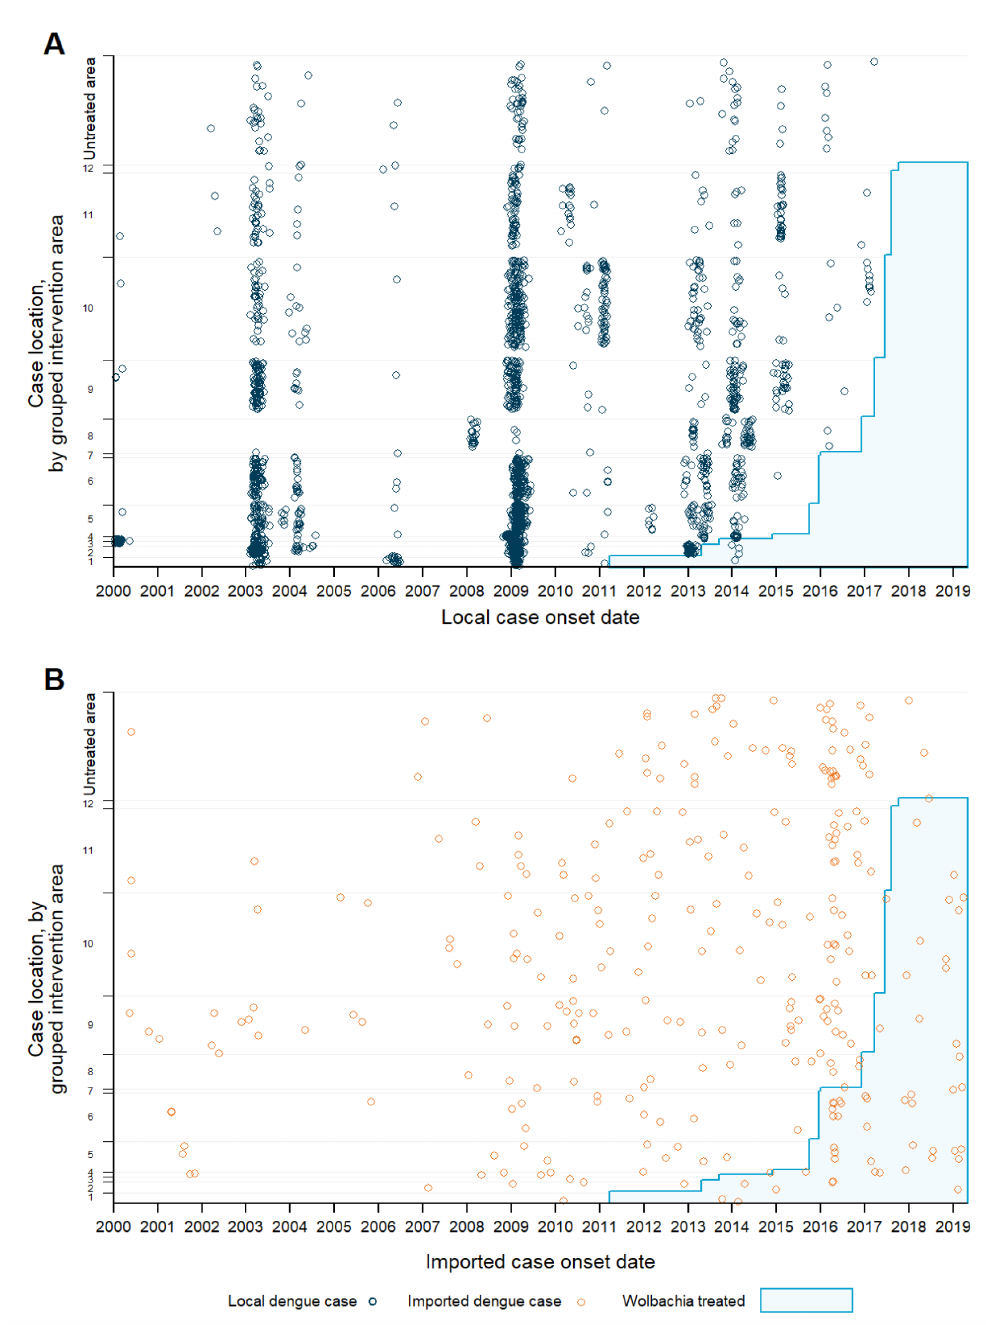
Figure 18. Notifications of locally-acquired ( A ) and imported ( B ) dengue cases relative to Wolbachia deployments, in Cairns, Cassowary Coast, Charters Towers and Douglas local government areas, January 2000 – March 2019. Cases are plotted by date of illness onset, and by grouped intervention area determined from geolocated address, or from suburb where address was unavailable. Intervention areas were grouped by the calendar quarter in which releases were completed or, for the five central Cairns non-release areas where Wolbachia established, the inferred date when local Wolbachia frequency reached 80%. Cases located in the four LGAs, but outside of any Wolbachia established area, are shown in ‘Untreated area’ at the top of each graph. The Y-axis scale is proportionate to the population size of each intervention area (or untreated area). The grouped intervention areas, and the quarter in which they were considered Wolbachia -treated for epidemiological purposes, were as follows: Group 1: Q1 2011 (GV, YK); Group 2: Q2 2013 (EHW, PP, WC); Group 3: Q3 2013 (BA, MB); Group 4: Q4 2014 (BU1, BU3, CN1, SF1-3); Group 5: Q3 2015 (MDA, MRA, BUN NR, EA); Group 6: Q4 2015 (M BU2, BUX1, BUX2, MDA NR1, MDA NR2, MS, OO, WCX1, WCX2, WO, WR); Group 7: Q1 2016 (WC NR); Group 8: Q4 2016 (CB, CT, MG, MN, MO, PD); Group 9: Q1 2017 (BP, CNX, EDM); Group 10: Q2 2017 (BEL, BH, BRN, BUX3, EHX, FFP, IAE, IES, INN, KB, MOU, MRAX, MSX, MUN, POR, PPX, SJO, WAN, WFX, WRX); Group 11: Q3 2017 (AER, BBY, CB, ELA, HB, FW, KWB, NMB, PC, SMB, SMF, TRB, TRP, TUL, WGB); Group 12: Q4 2017